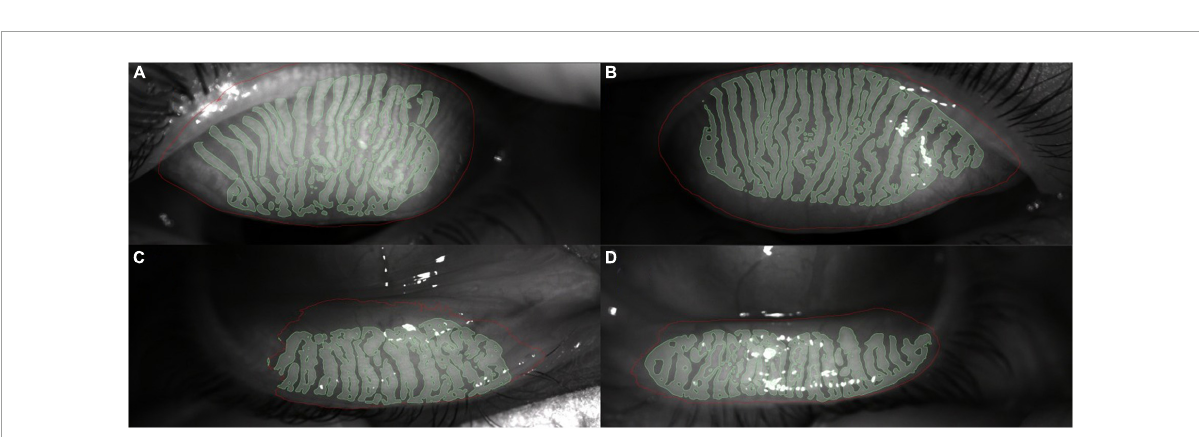
FIGURE6 Meibomian gland pattern and dysfunction measured with an infrared non-contact camera. All images were real, and the green zone automatic or manual establishes glands presence. (A) Right eye upper eyelid real meibomian gland pattern. (B) Left eye upper eyelid real meibomian gland